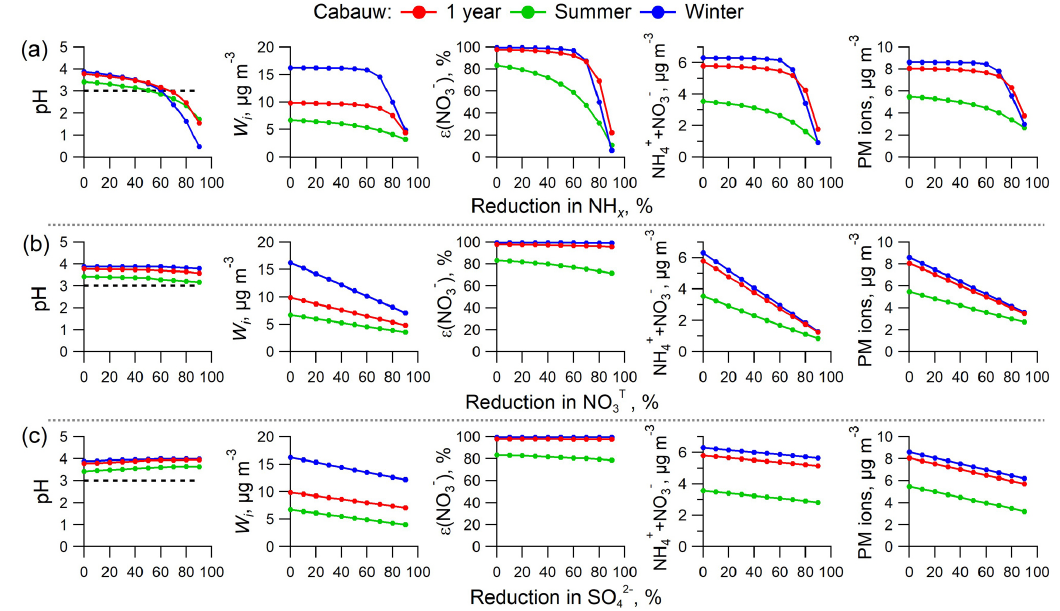
Figure 4. ISORROPIA-predicted PM 2 . 5 pH (first column), liquid water content ( W i , second column), ε (NO − ) (third column), ammonium 3 + NH and nitrate (fourth column), and aerosol inorganic mass concentrations (fifth column) as a function of changes in NH x (NH + 3 , first 4 2 − + HNO row), NO 3T (NO − (third row). Simulations are based on average conditions of 1-year, summer, and winter 3 , second row), and SO 3 4 observational data in Cabauw, the Netherlands, and changing only NH x , NO T , and SO 2 − from the average conditions. The black dashed 3 4 lines in the pH figures identify the critical pH value of